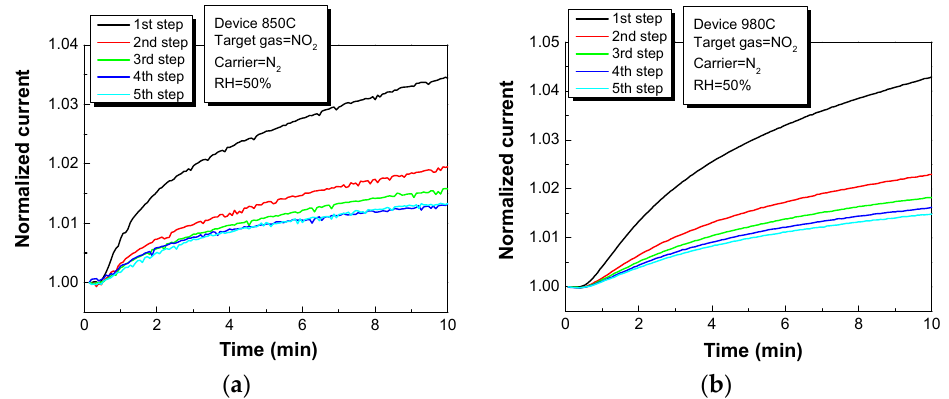
Figure 3. ( a ) Normalized current signals recorded upon the exposure to the 5 sequential pulses as reported in Figure 2b for device “ 850 °C ”; Plots in panels ( b ) refer to device “ 980 °C